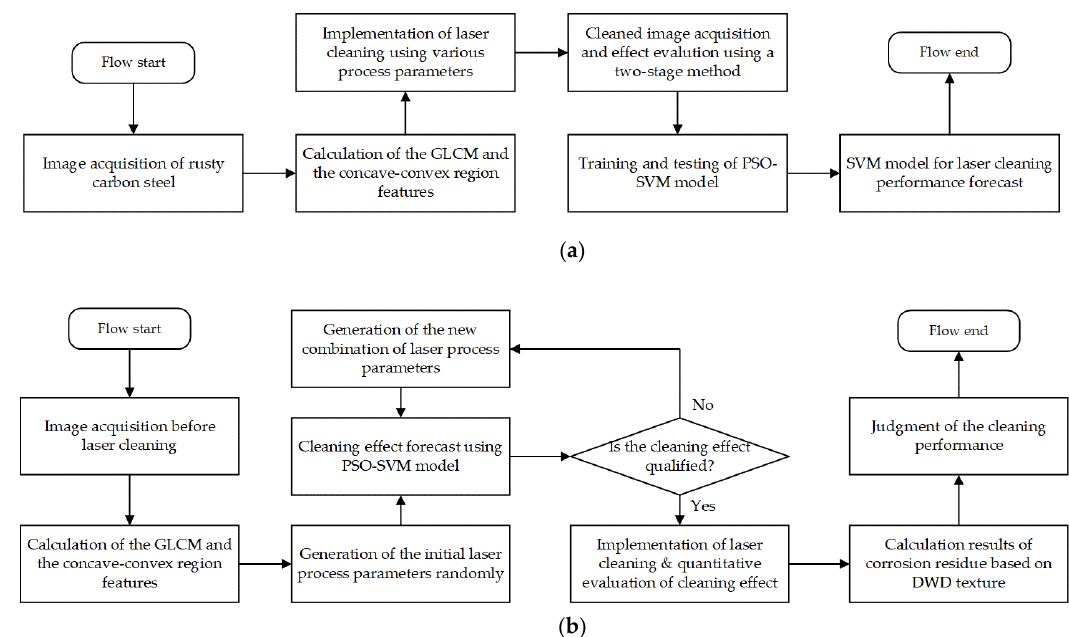
Figure 2. Flow chart of the proposed intelligent laser cleaning methodology. ( a ) The offline processing flow chart; ( b ) the online processing flow chart.